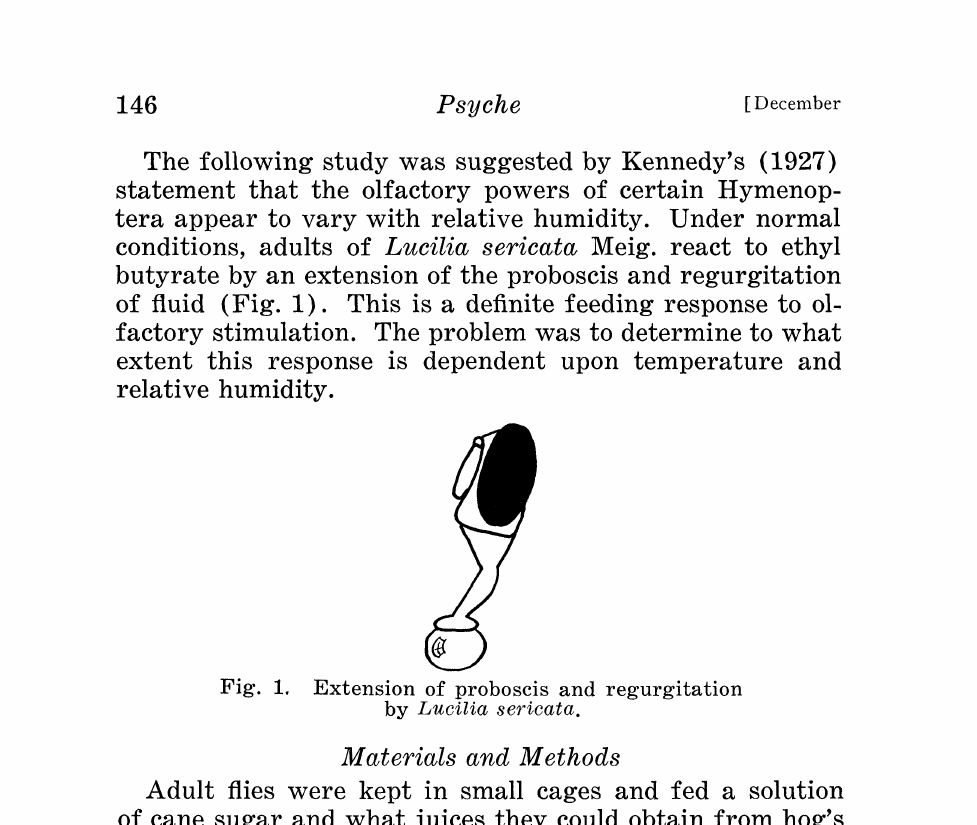
Fig. 1. Extension of proboscis and regurgitation by Lucilia